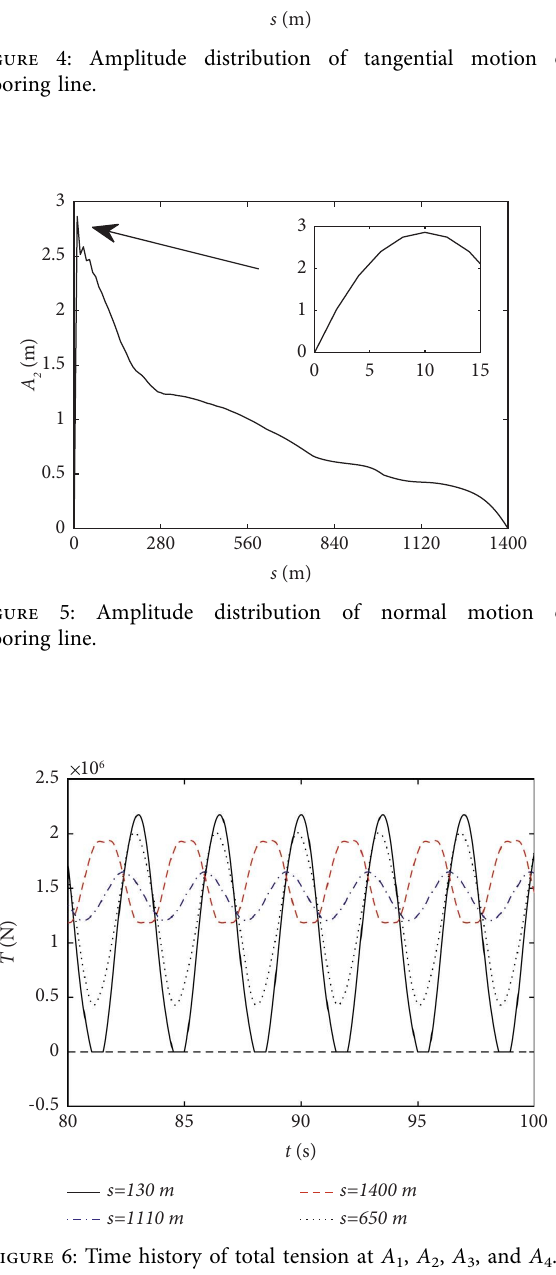
1 , A 2 , A 3 , and A 4 .